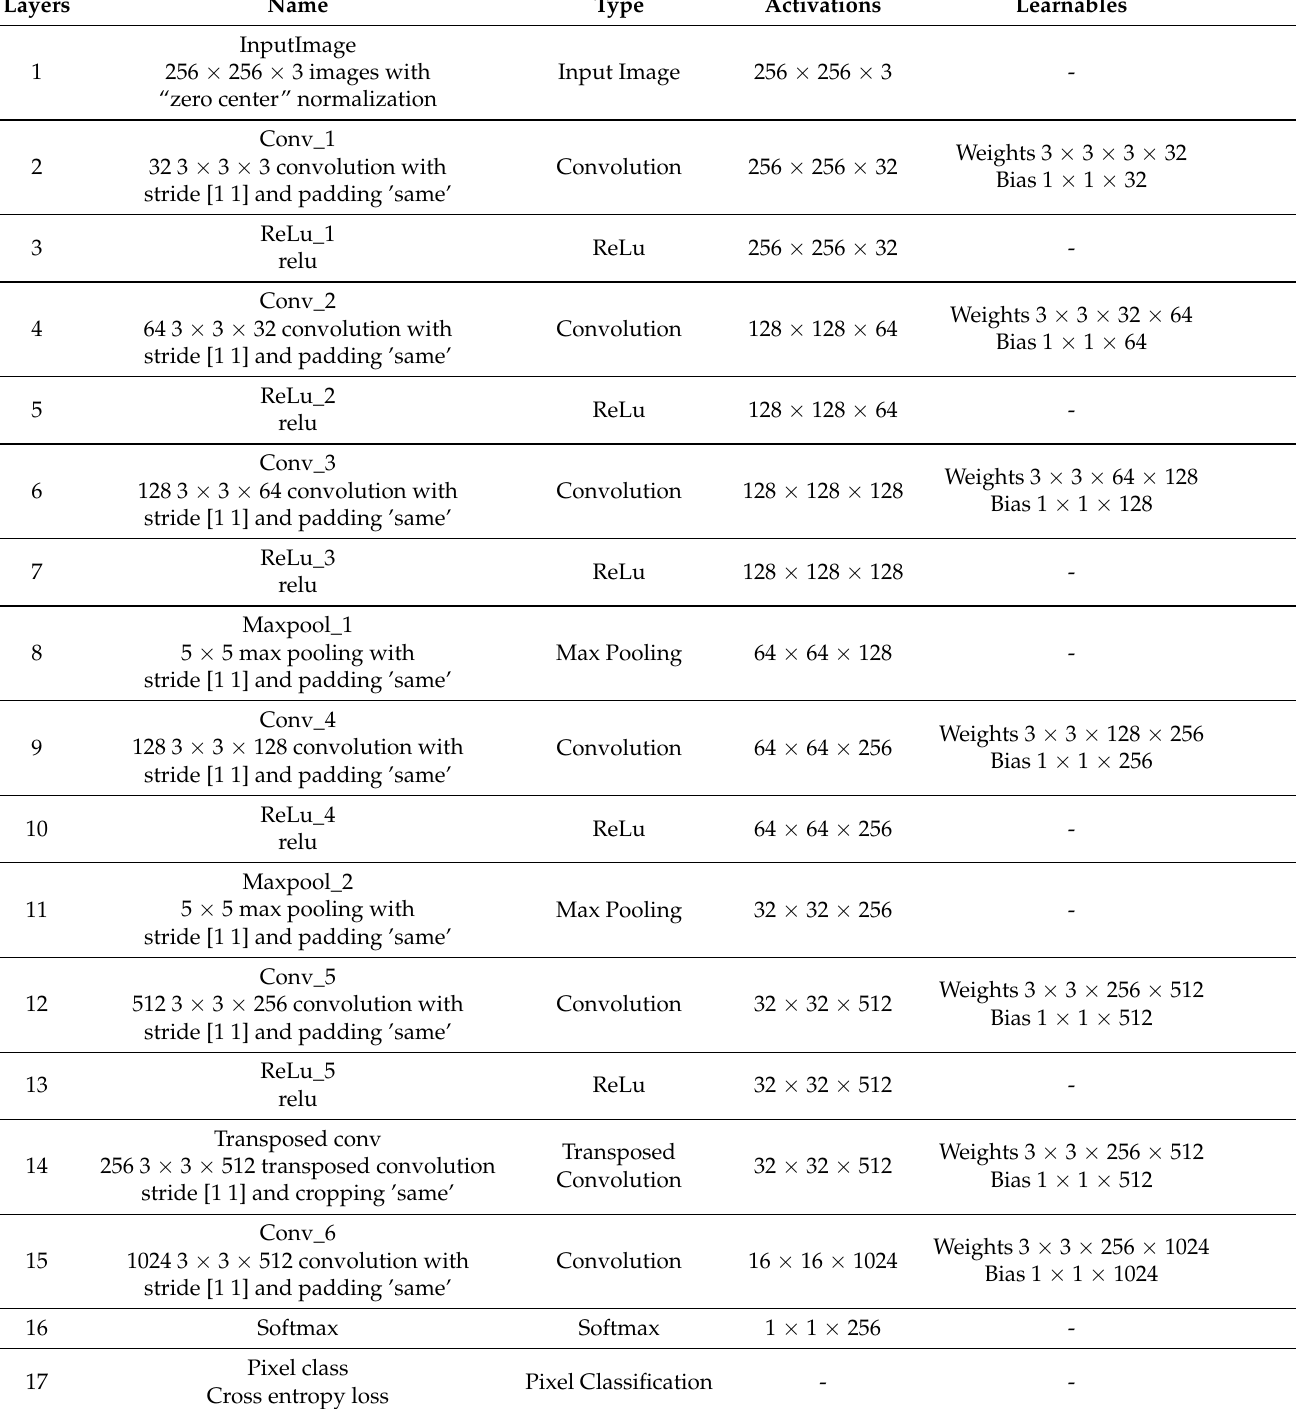
Table 2. Proposed CNN architecture